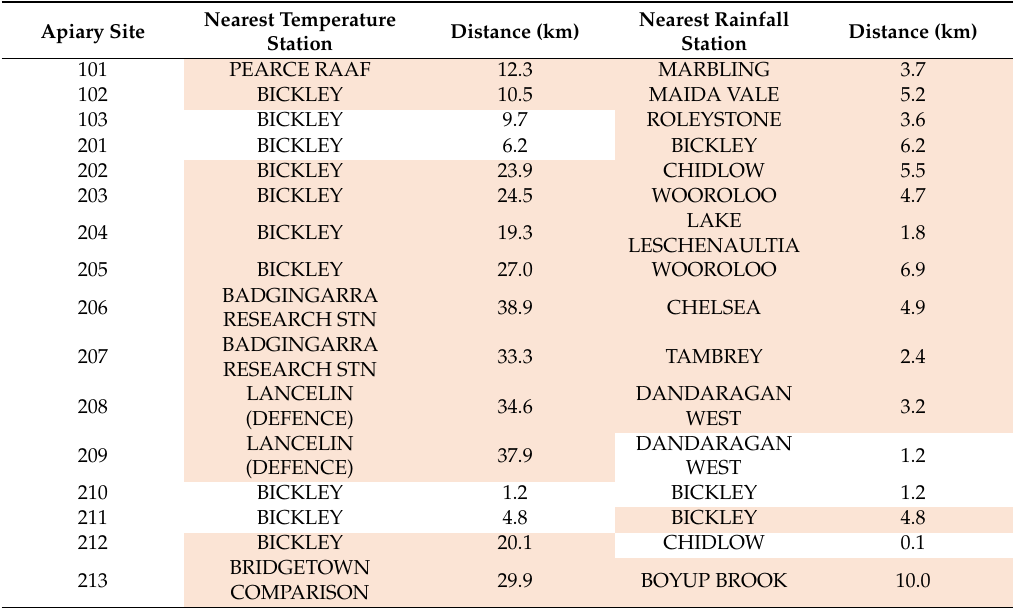
Table 3. Distances between apiary sites and weather stations Bureau of Meteorology (BOM) weather station locations retrieved from [17].